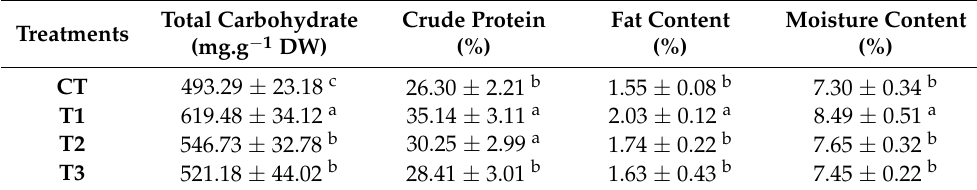
Table 4. Impacts of diverse iron sources (nano, chelated, and sulfate), as foliar spray on seed moisture and some metabolites